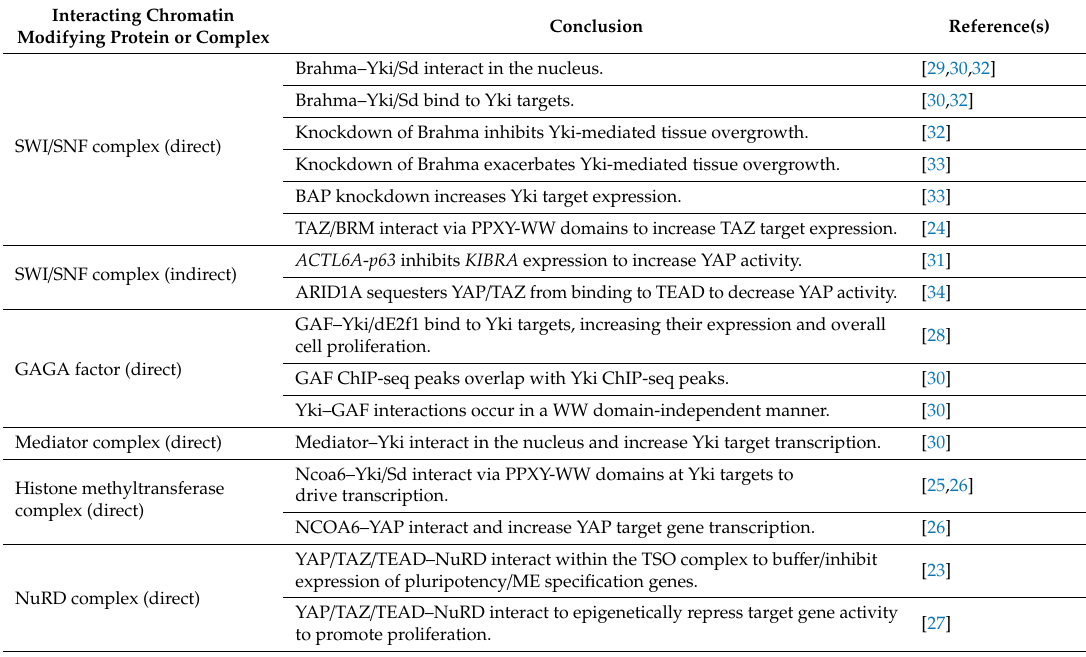
Table 1. Documented Yki / YAP / TAZ interactions with chromatin-modifying proteins. Interacting Chromatin Modifying Protein or